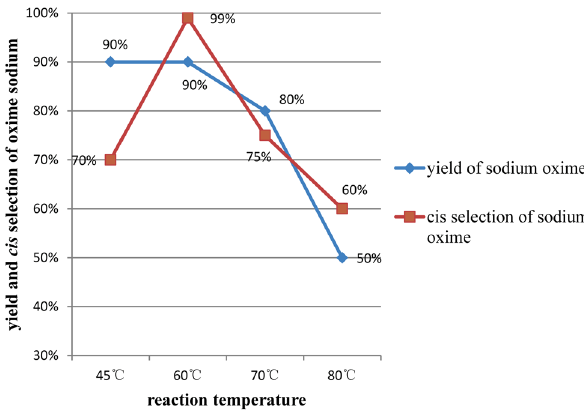
Figure 2: E ff ect of temperature on the yield of sodium oxime and proportion of cis - sodium